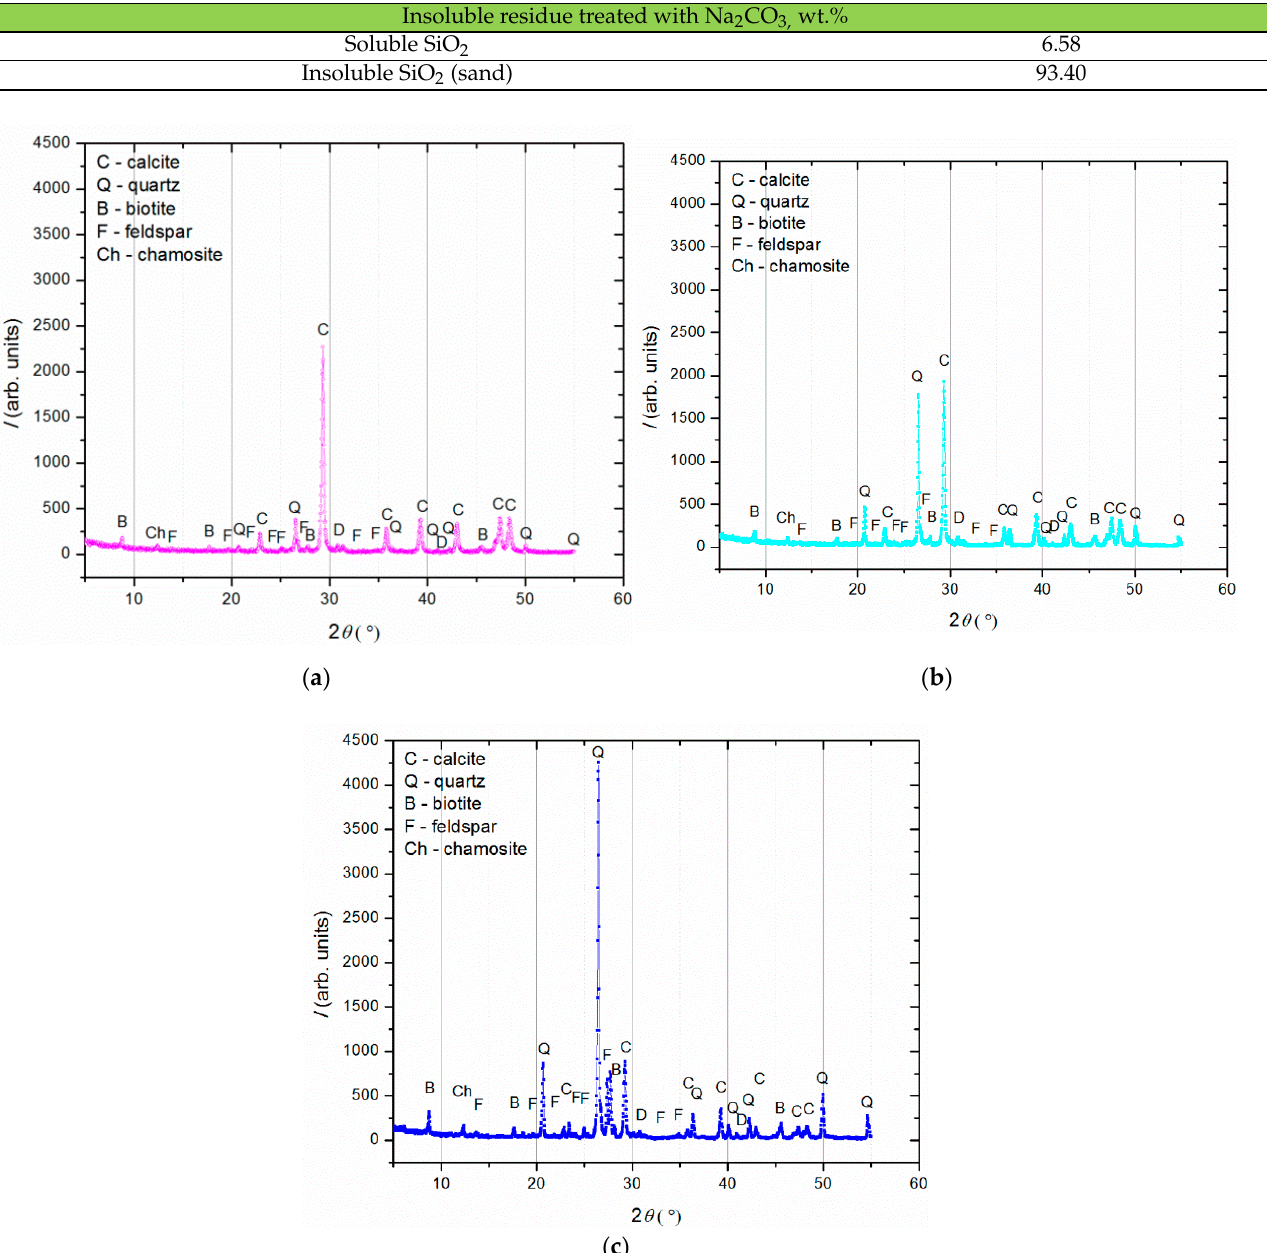
Figure 4. XRD analysis of ( a ) binder (fraction <63 µm); ( b ) agglomerated binder/lumps (fraction >710 µm); ( c ) aggregate (710–63 µm). Table 2. Sieving analysis and optical microscopy of historical mortar sample, HM.